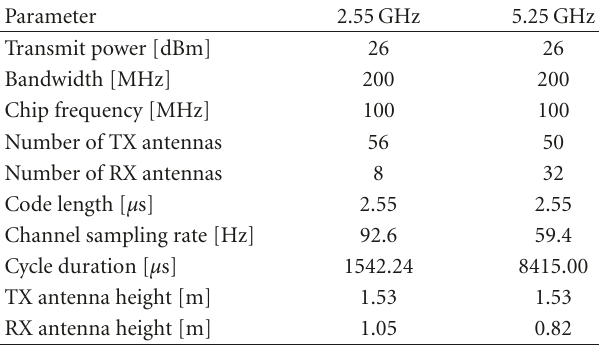
Table 2: Parameter settings for the PropSound Channel Sounder CS